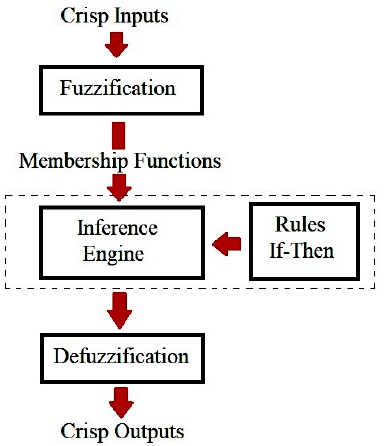
Figure 1. Block diagram of a fuzzy logic control system.